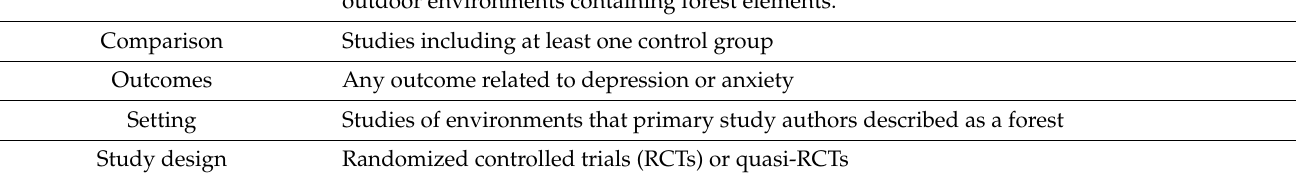
Table 1. Inclusion criteria based on PICO-SD (Population, Intervention, Comparison, Outcomes, Setting, and Study design). PICO-SD Inclusion Criteria Population Studies with humans, healthy or not.